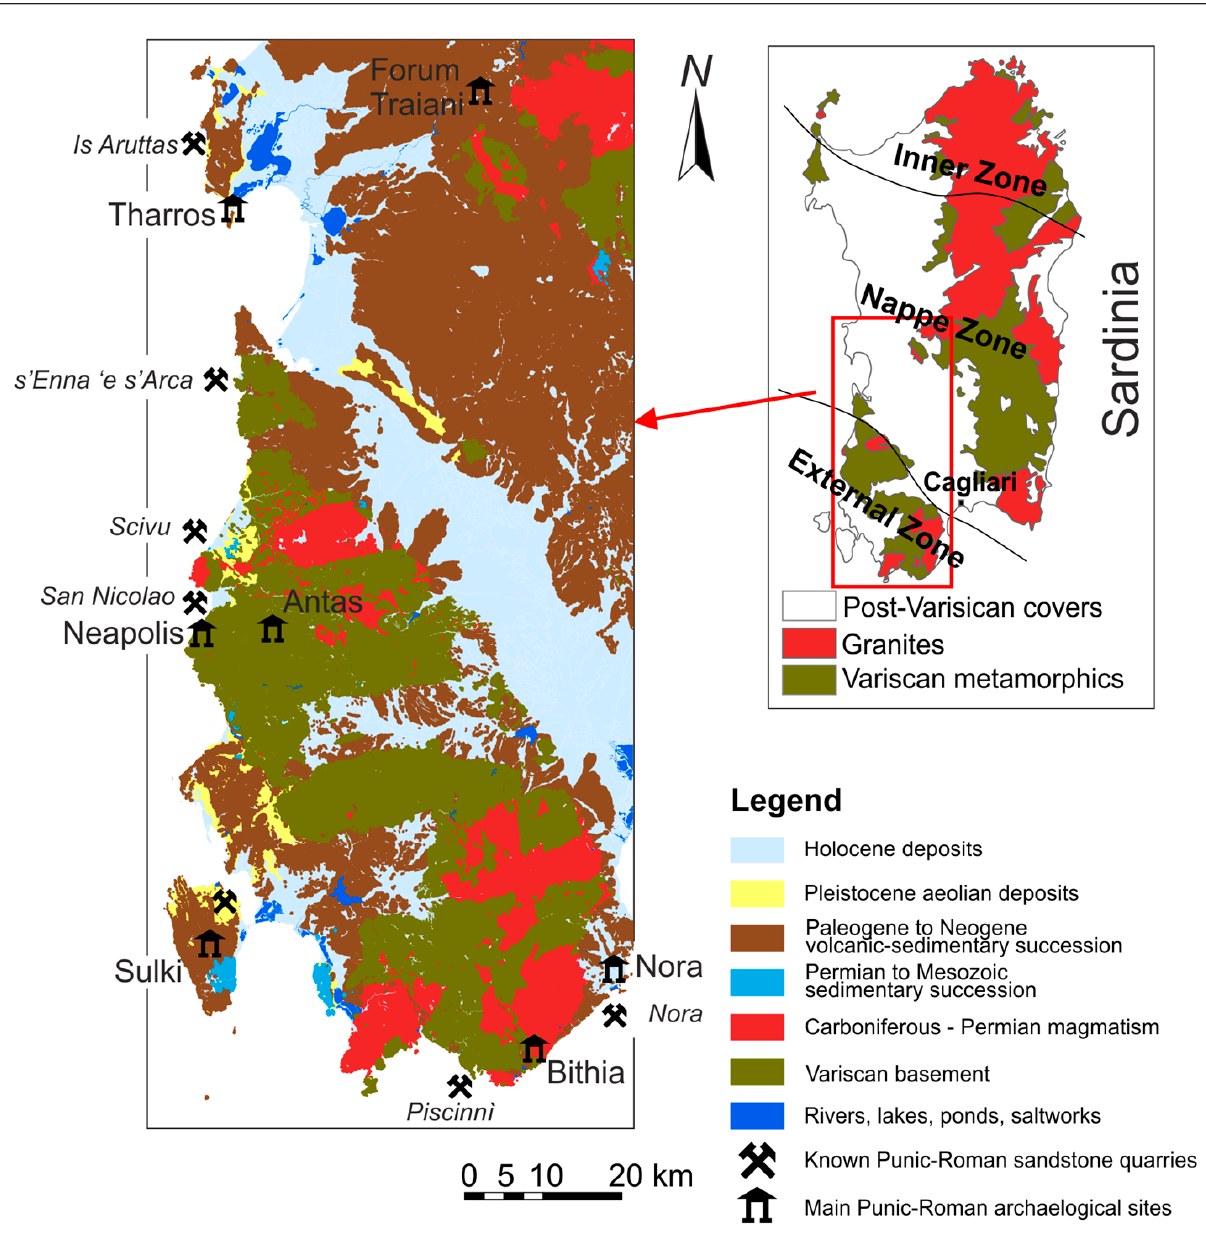
Figure 4. Geological sketch-map of the southwestern Sardinia coast with the location of the Antas Temple and other important archaeological sites from Punic and Roman times such as Tharros , Forum Traiani , Neapolis (with probable localization near to Antas site), Sulki , Bithia , Nora , and ancient Punic-Roman quarries, such as Is Aruttas , s’Enna ‘e s’Arca , Scivu , San Nicolao , Piscinn ì , Fradis Minoris and Sa Perderedda (near to Nora site). Geological base from RAS, 2010, modified [51].